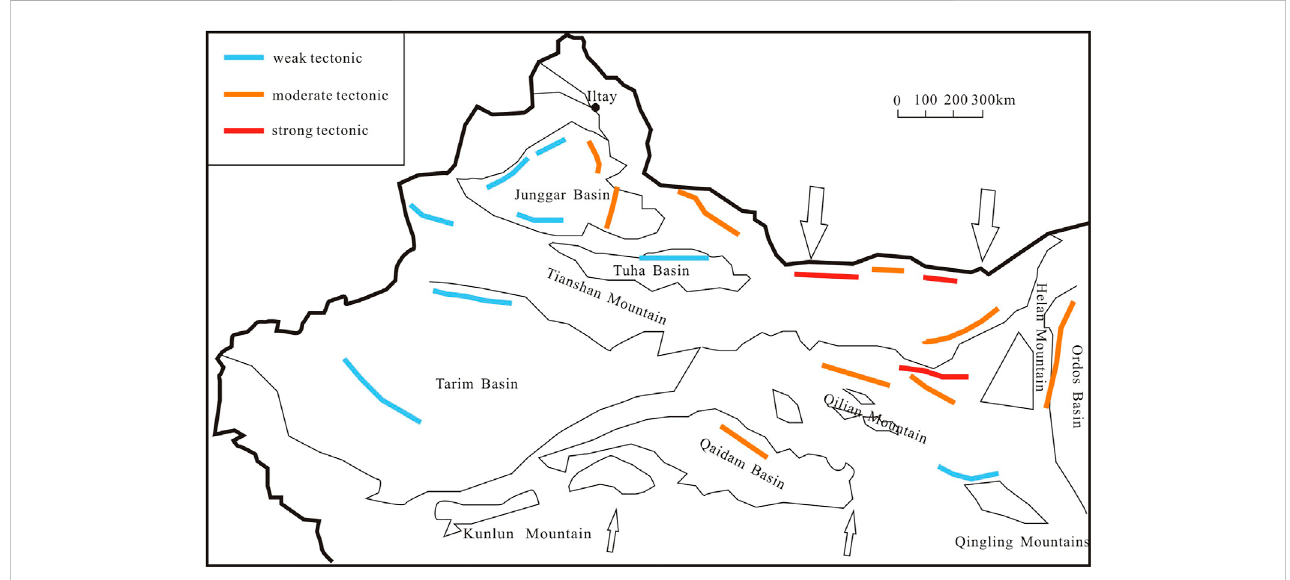
FIGURE 8 Structural strength characteristics of middle Yanshanian in Northwest China (modi fi ed from Chen et al., 2004).